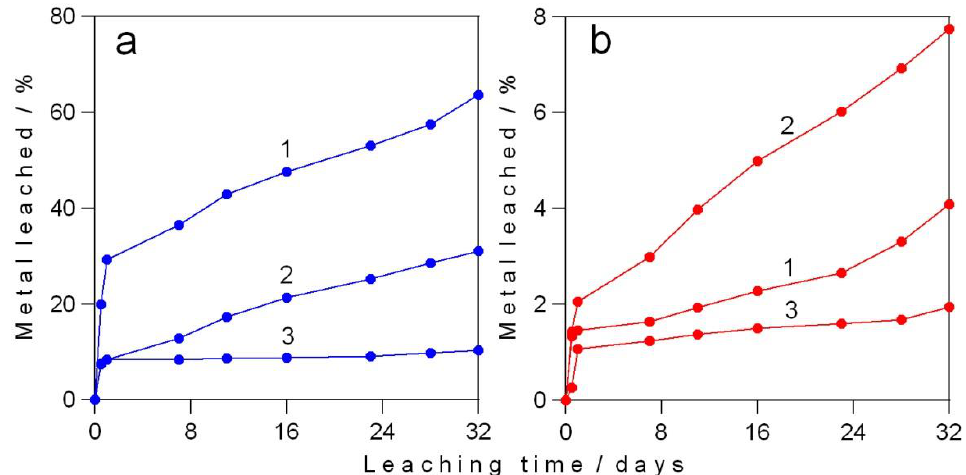
Figure 3. Kinetics of nickel ( a ) and copper ( b ) leaching from the ore samples. Deposits: Lake Moroshkovoye (1), Nittis-Kumuzhya-Travyanaya (NKT) (2), and Nyud Terrasa (3).